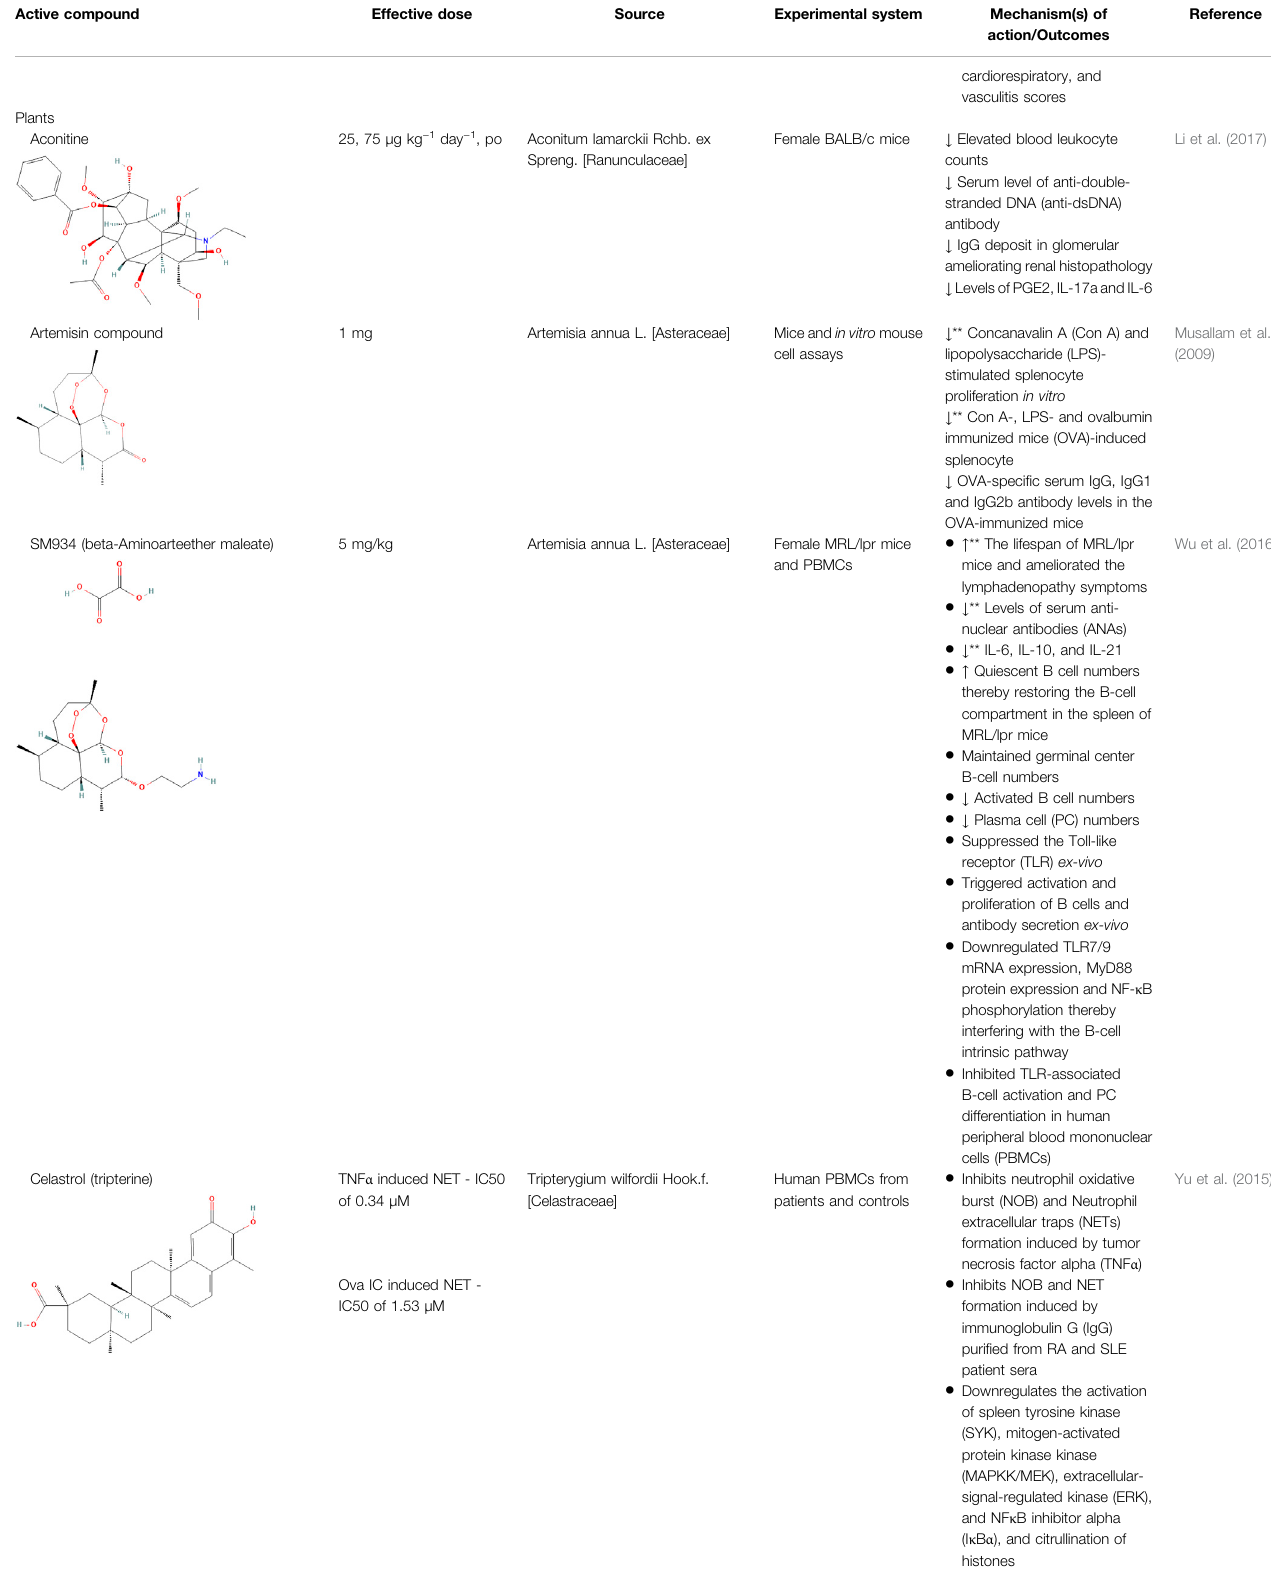
TABLE 1 | ( Continued ) Synthesized fi ndings for potential bioactive compounds for